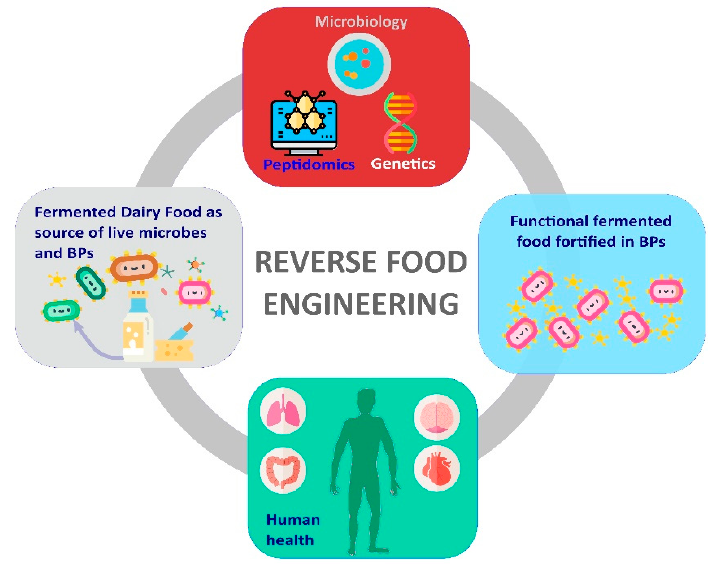
Figure 2. Overview of reverse food engineering approach. Reverse food engineering exploits fermented dairy foods (FDFs) as bio-reservoirs of microbes producing BPs and pro-health molecules and performs multidisciplinary analysis to improve content of BPS and healthy microbes in hyperfood.